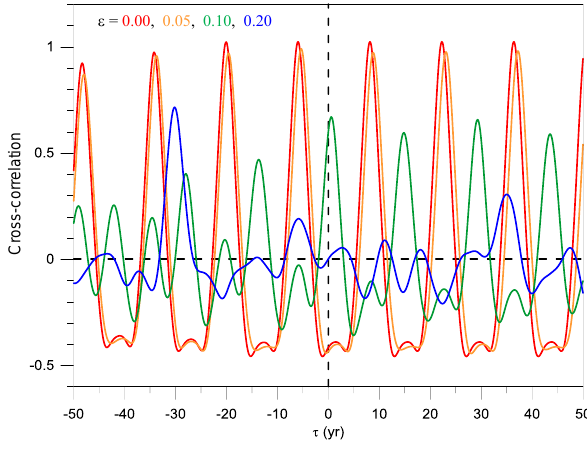
Figure 10. Cross-correlation c(τ) between the two initially nearby trajectories shown in Fig. 9a–d, computed for the centered and nor- malized anomalies e (cid:57) 3 , according to Eq. (7), for ε = 0 (red line), 0 . 05 (orange line), 0 . 1 (green line) and 0 . 2 (blue line).